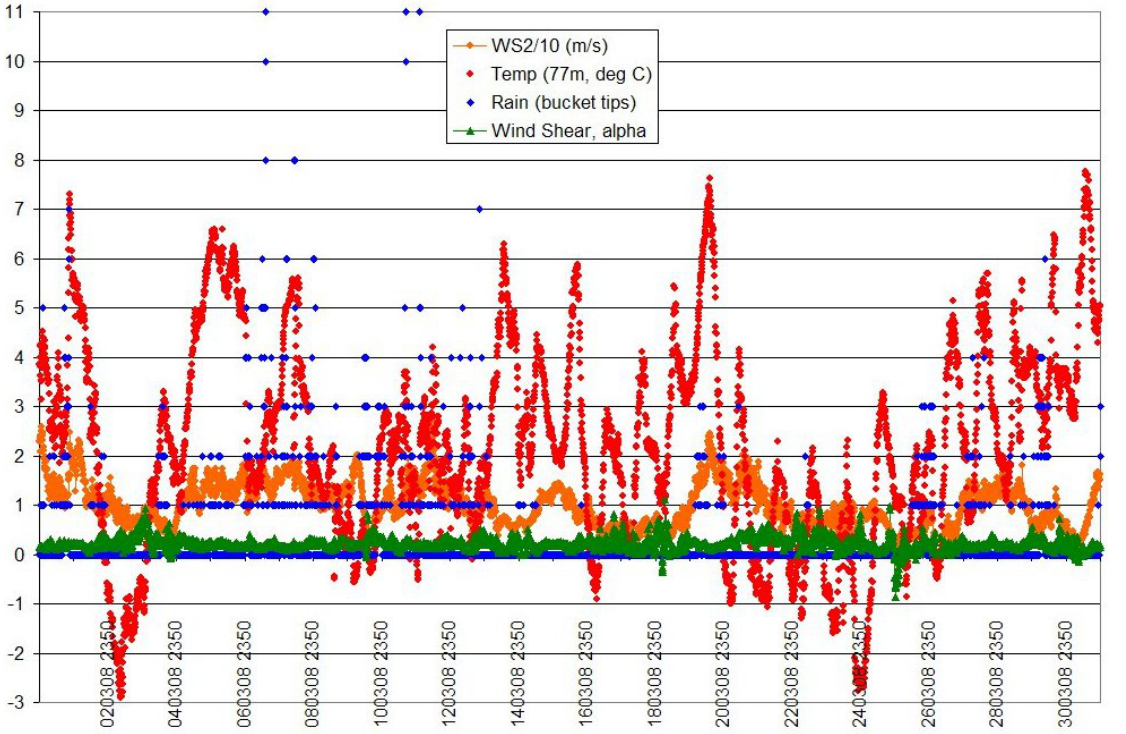
Figure 12. Selected meteorological characteristics for March